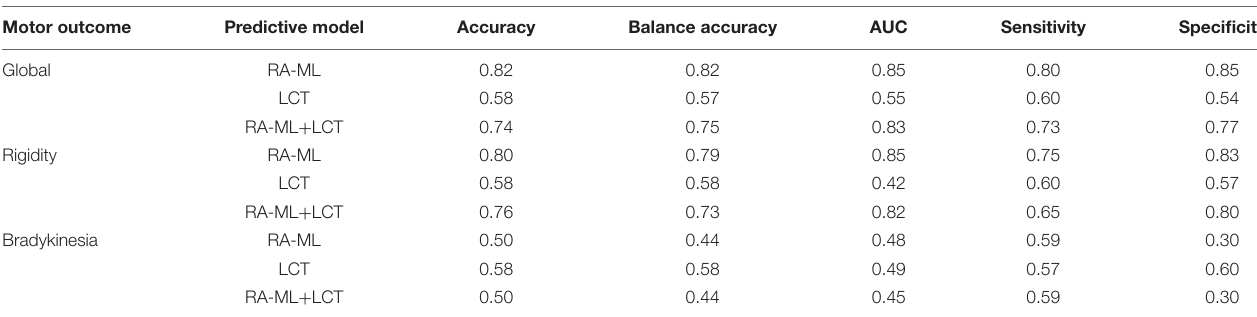
TABLE 2 | Predictive performances of the three